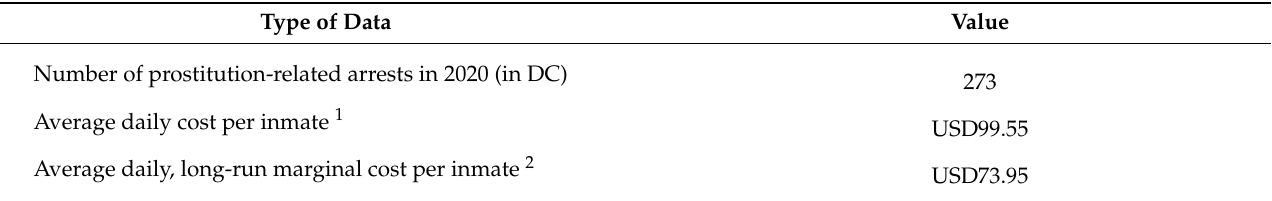
Table 2. Values of data used to calculate criminal justice system savings following decriminalization (monetary values in 2020 USD).